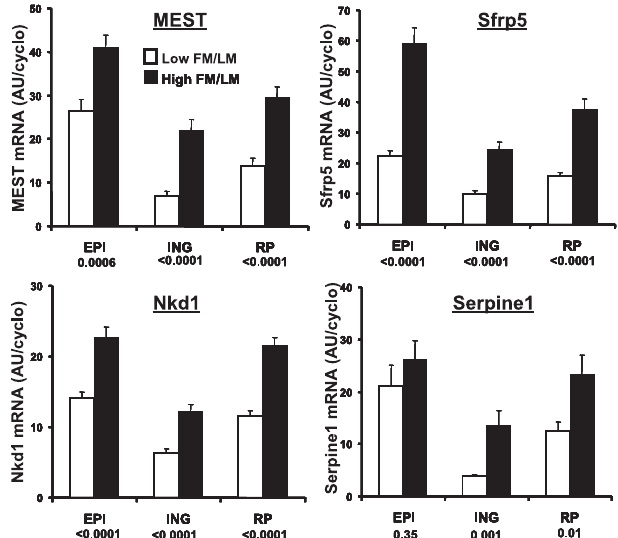
Figure 5. Over-Expression of Four Genes in High Gainer Mice in Two Peritoneal Fat Depots and One Subcutaneous Fat Depot Illustrates that the Mechanism Leading to Over-Expression of These Genes Occurs in All Fat Depots Statistical significance was calculated by ANOVA. Twenty mice were present in each